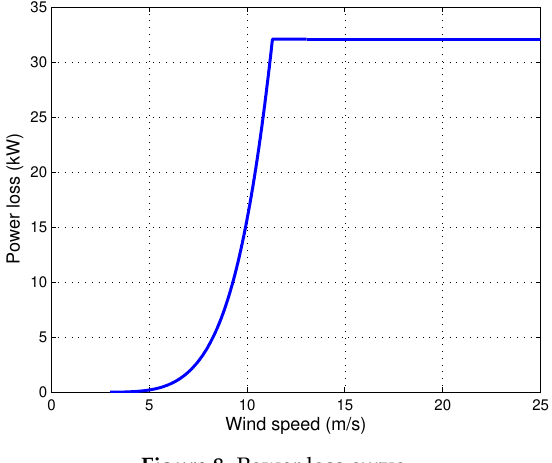
Figure 8. Power loss curve.